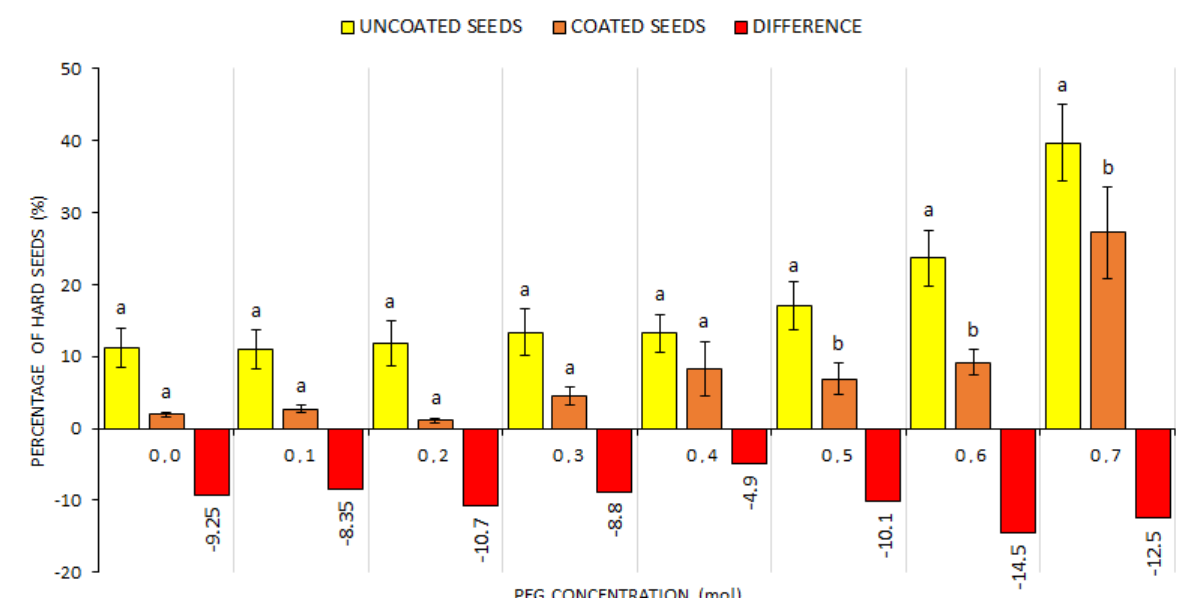
Figure 4. The comparison of dead seed percentages within US and CS treatments at different drought simulation degrees. Average values for all indicator plants for the US (uncoated seeds; n = 20 ± SE; average of all plant species) and CS (coated seeds; n = 20 ± SE; average of all plant species) treatments with PEG concentrations = 0.0 – 0.7 mol; different lowercase letters indicate significant difference (ANOVA post-hoc Tukey´s HSD test; p < 0.05) for the respective parameters between the US and CS groups.